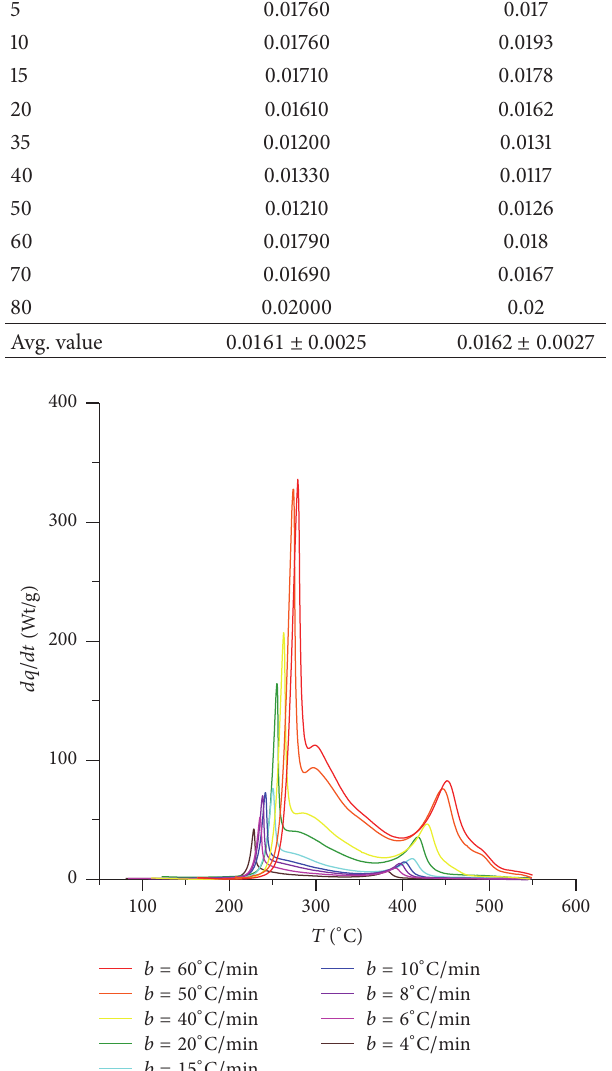
Figure 5: Kinetic curves of light oil oxidation adsorbed on crushed carbonate rocks in the DSC at a pressure of 5 MPa.